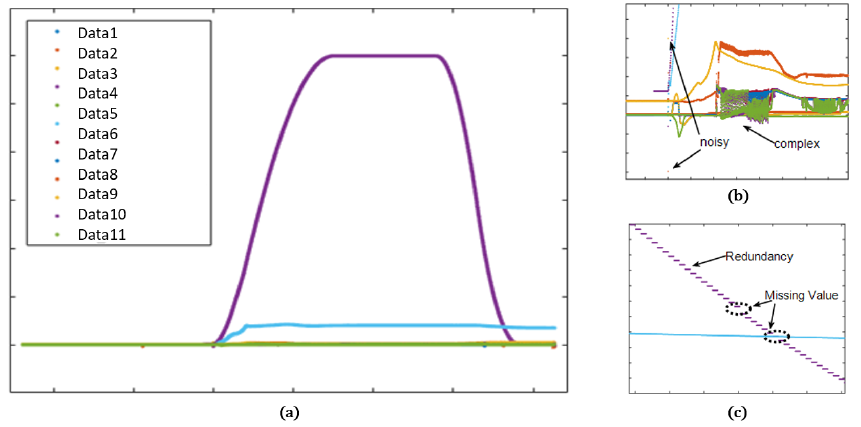
Figure 4. Missile data plot: ( a ) full view; ( b ) magnified plot with noisy and complex values; ( c ) magnified plot with redundant and missing values.